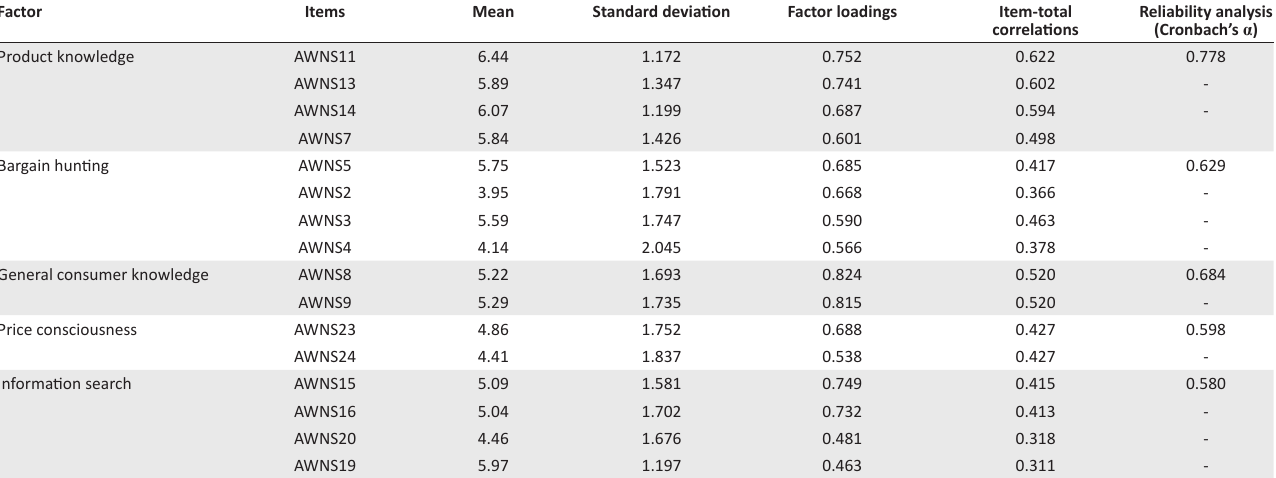
TABLE 3: Results of exploratory factor analysis.